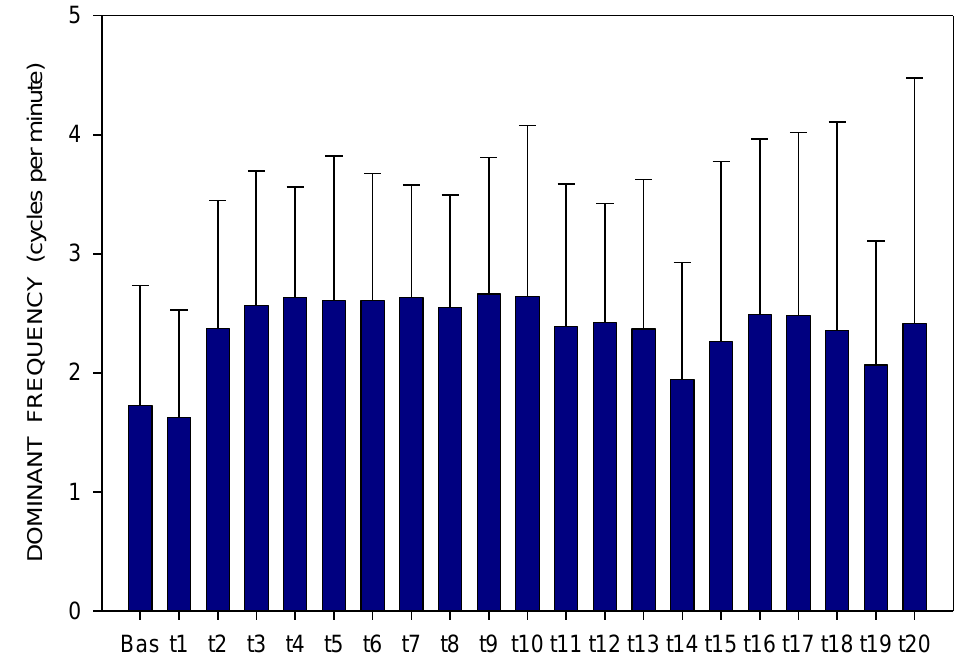
Figure 2. Electrogastrography. Dominant frequency before and after a single intragastric dose of 24 mg galantamine in animals with previous 7-day administration of dextran sodium sulphate (mean + standard deviation). Explanatory note: Bas: 15-min basal recording before galantamine administration; t: 15-min study recordings after galantamine administration (t1: time interval between 0–15 min ... t20: time interval between 286–300